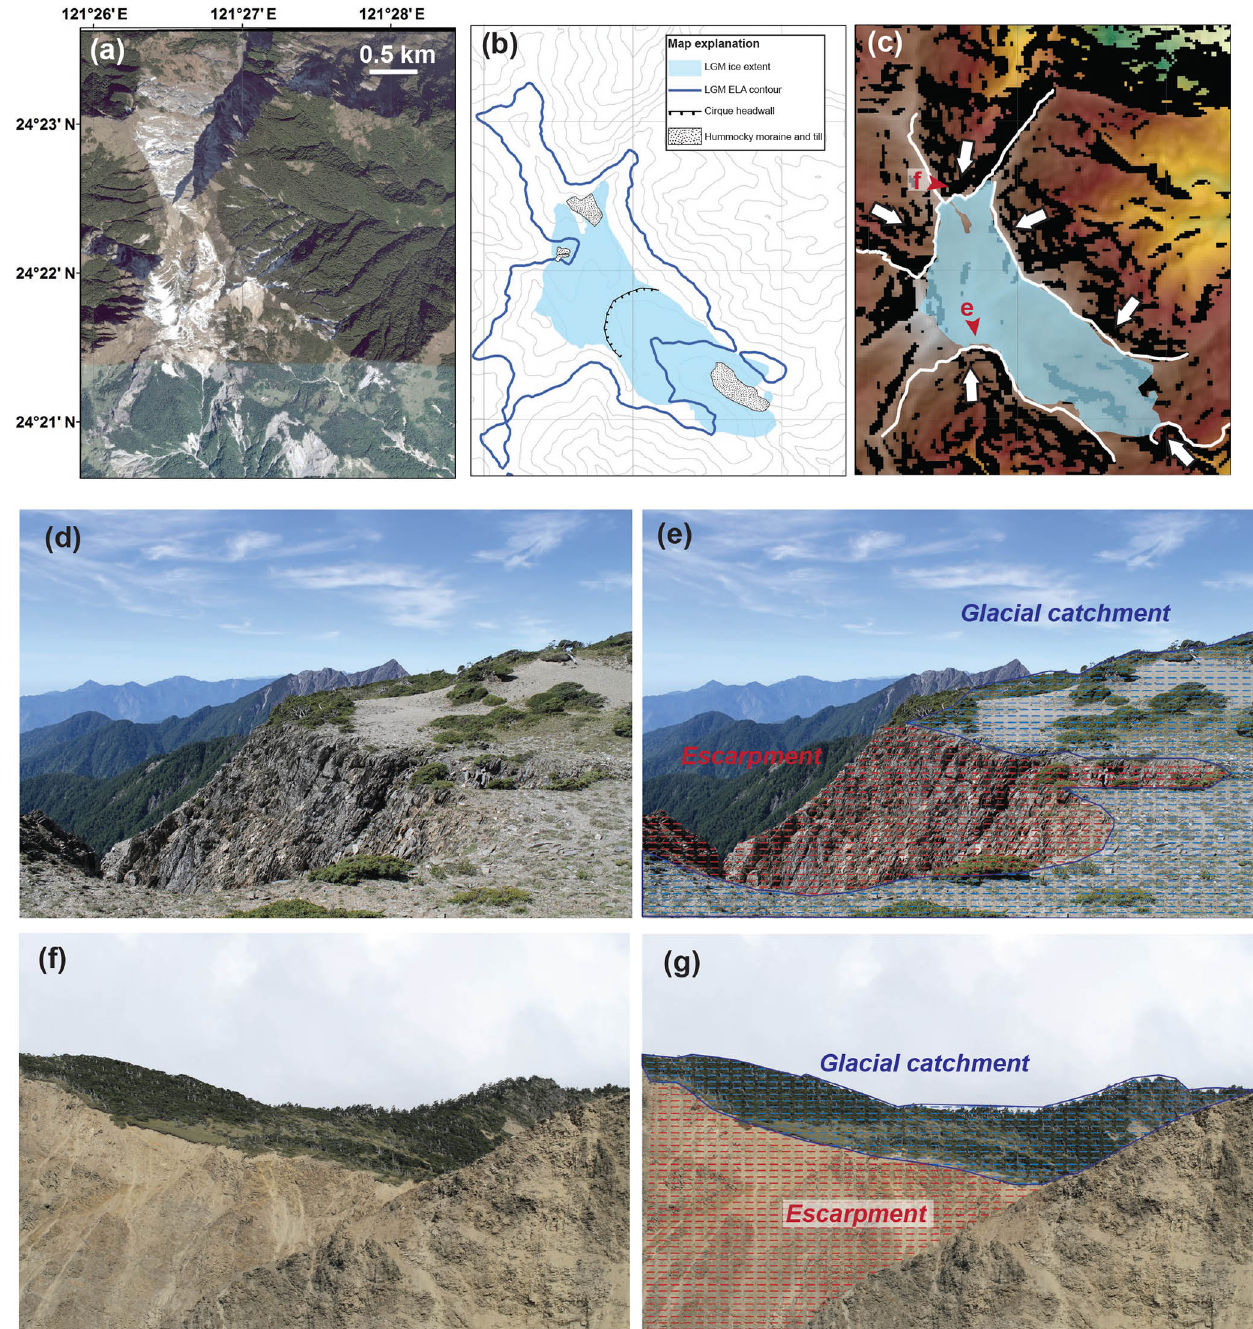
Figure 10. Nanhudashan glacial geomorphology. (a) Satellite image of Nanhudashan (Google Earth). (b) Simplified glacial geomorphic map of Nanhudashan. Heavy blue line is contour of estimated LGM ELA at 3400m. Contour interval is 100m. (c) SRTM DEM (green through red). Light blue is mapped ice extent. White lines are escarpments, and white arrows indicate direction of scarp encroachment. (d–g) Field photos of mapped escarpments. Blue and red zones in panels (e) and (g) correspond to glaciated zone and escarpment. Vantage point for panels (d) and (f) labeled with red arrows in panel (c)